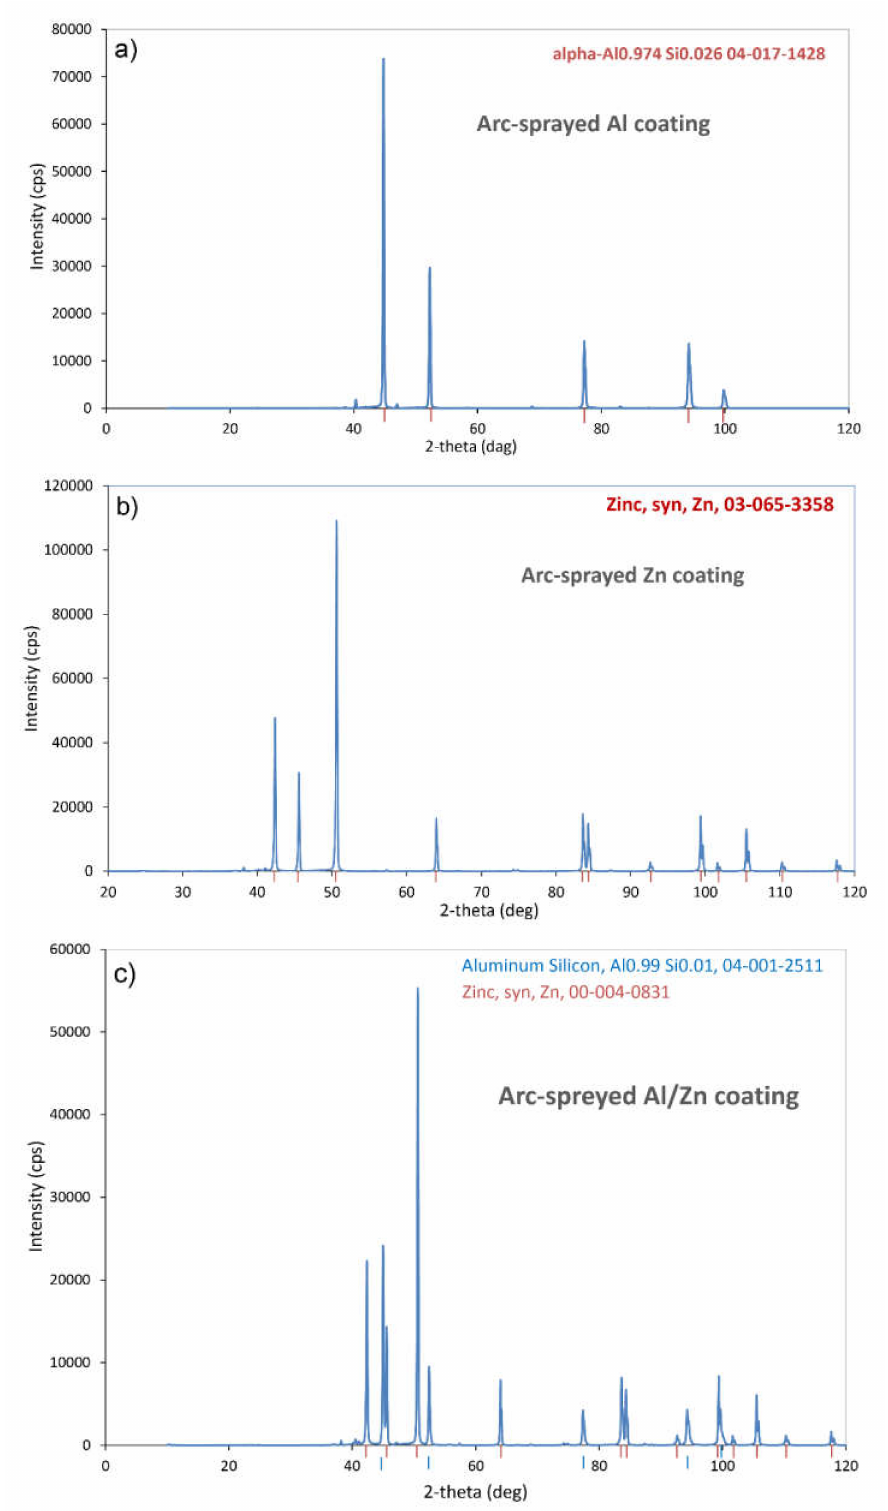
Figure 2. XRD patterns of ( a ) Al; ( b ) Zn and ( c ) Zn-Al arc-sprayed coatings, respectively. For the arc-sprayed Al coating, similar to the Zn coating, no aluminum oxides were found in the dark gray structure with homogeneous grain morphology based on the Al0.974Si0.026 phase as confirmed by the XRD pattern (Figure 2b). Although the aluminum wire material is chemically active during arc sputtering, the molten wire particles do